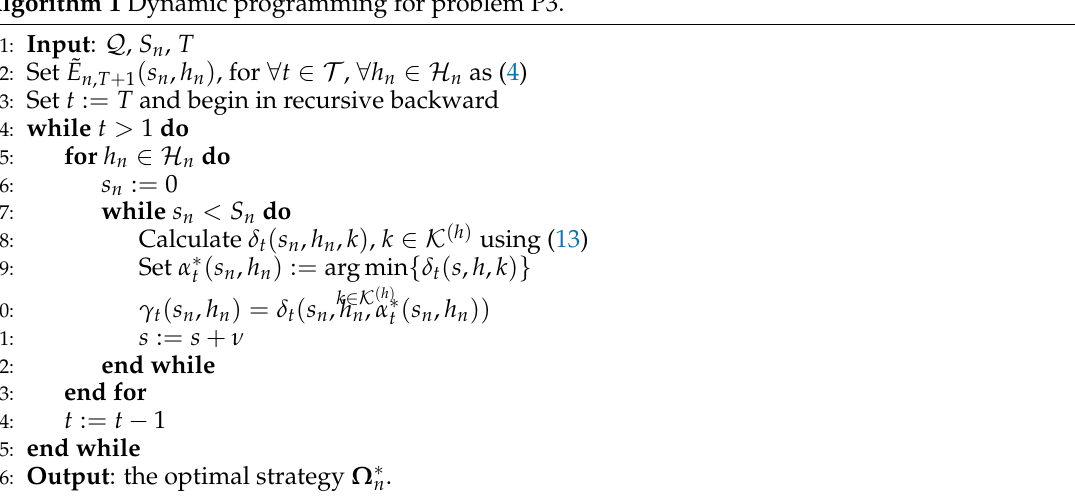
Algorithm 1 Dynamic programming for problem